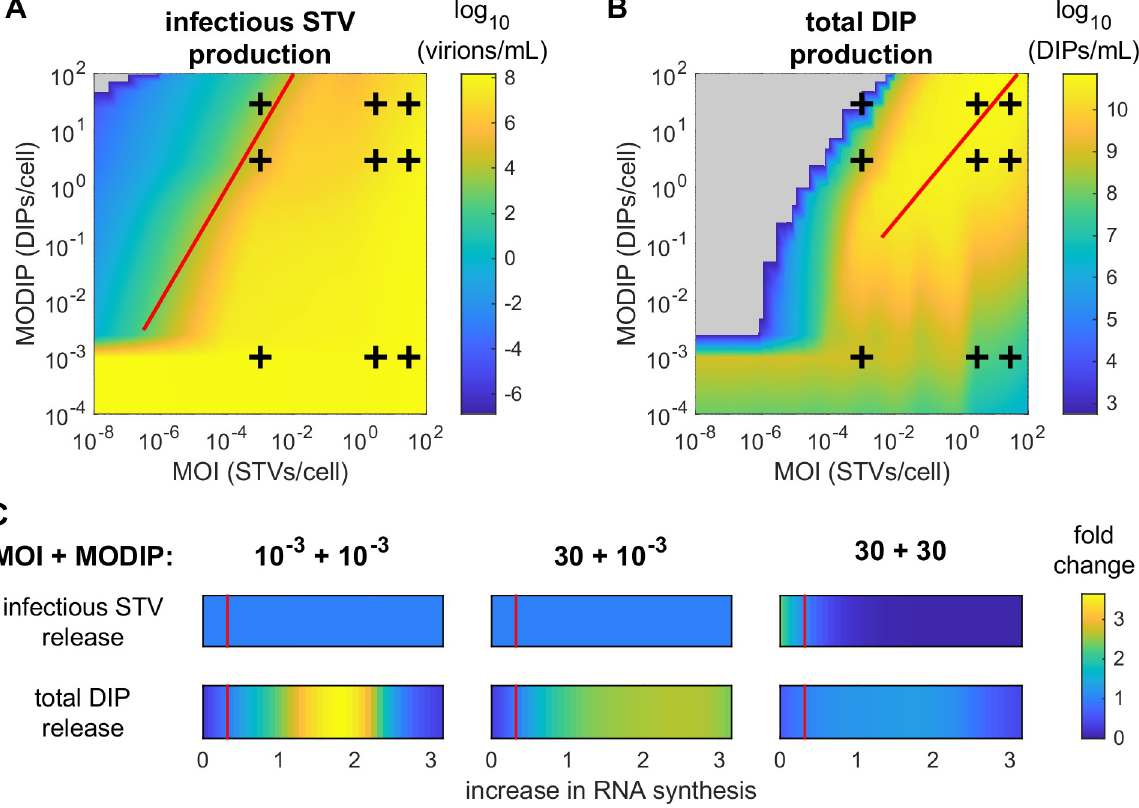
Fig 6. STV infection suppression and DIP production are strongly affected by the infection conditions. (A+B) Infections of MDCKsus cells were simulated with the extended model using MOIs and MODIPs in the range of 10 − 8 –10 2 and 10 − 4 –10 2 , respectively. The predicted concentrations of (A) infectious STVs and (B) total DIPs at 48 hpi determine the color of the heat map. The experimentally observed infection scenarios (+) are depicted. The solid red line indicates (A) an MODIP-to-MOI ratio of 10 4 :1 and (B) the optimal multiplicity ratios for DIP production. For the switch between regular and reduced vRNA synthesis for low and high initial DIP concentrations a threshold value of F MODIP = 10 − 3 was used. Grey areas indicate that no production of either STVs or DIPs did occur. (C) The predicted fold-change for yields of infectious STVs and total DIPs at 24 hpi depending on a reduction or increase in the replication advantage of DI cRNAs over their FL counterpart is presented. The parameter F Adv was varied in the range of 0 to 1000% of its estimated value. The vertical red line indicates the replication advantage estimated during model calibration, i.e., F Adv = 0.32.